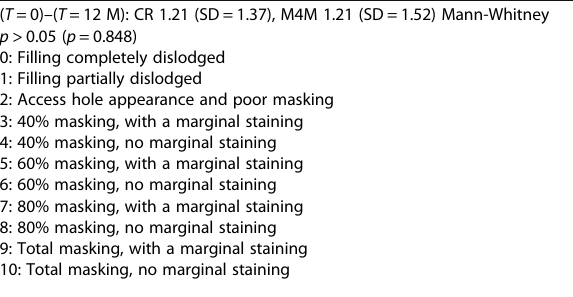
M4M. The marginal discrepancy patterns for both groups CR and M4M were different and shown in Fig. 7a, b.